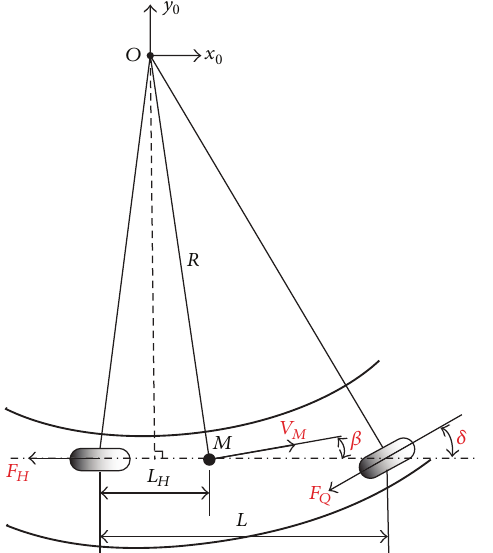
Figure 2: Force analysis of the single vehicle model and its dynamic